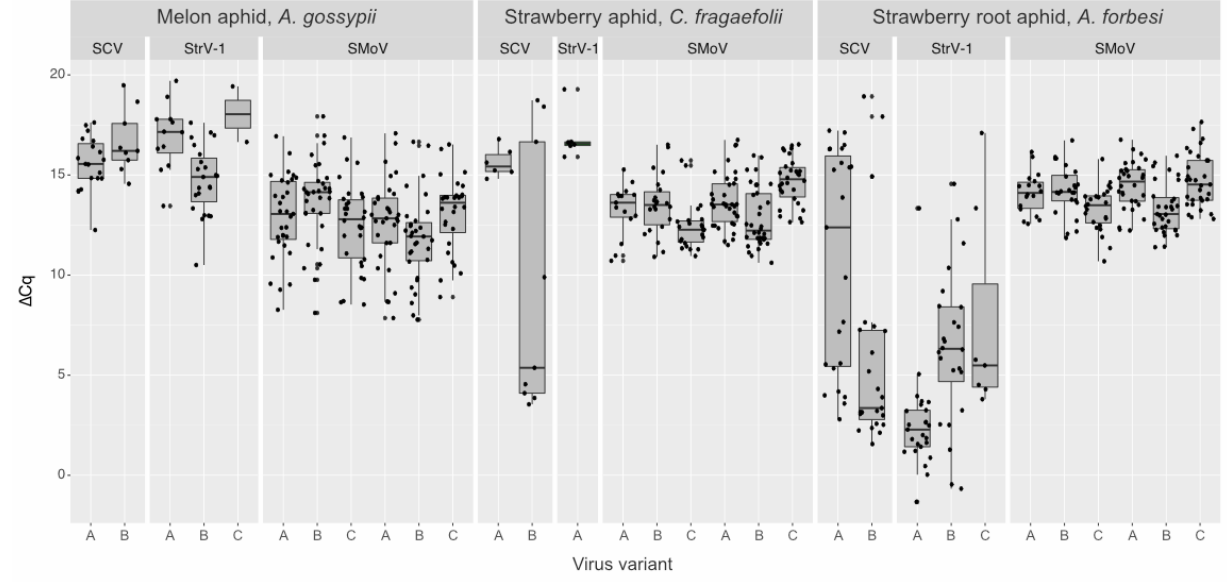
Figure 2. Boxplot distribution of ∆ C q values of SCV, SMoV and StrV-1 and their variants in three aphid species. Individual ∆ C q values are overplotted as points.